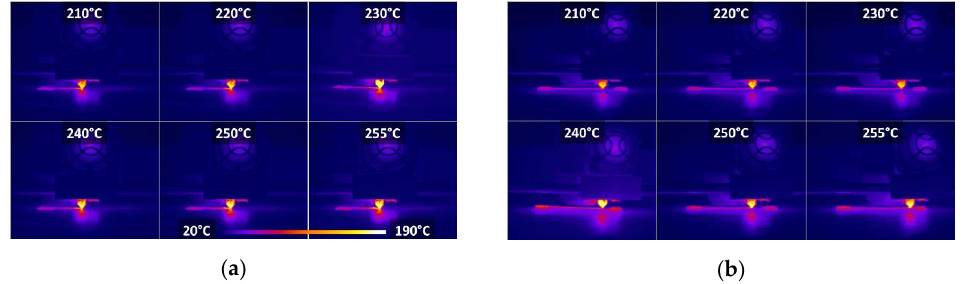
Figure 4. Infra-red recording of PLA temperature: ( a ) after the first 14 s and at; ( b ) the end of the printing sequence as a function of the printing temperature.